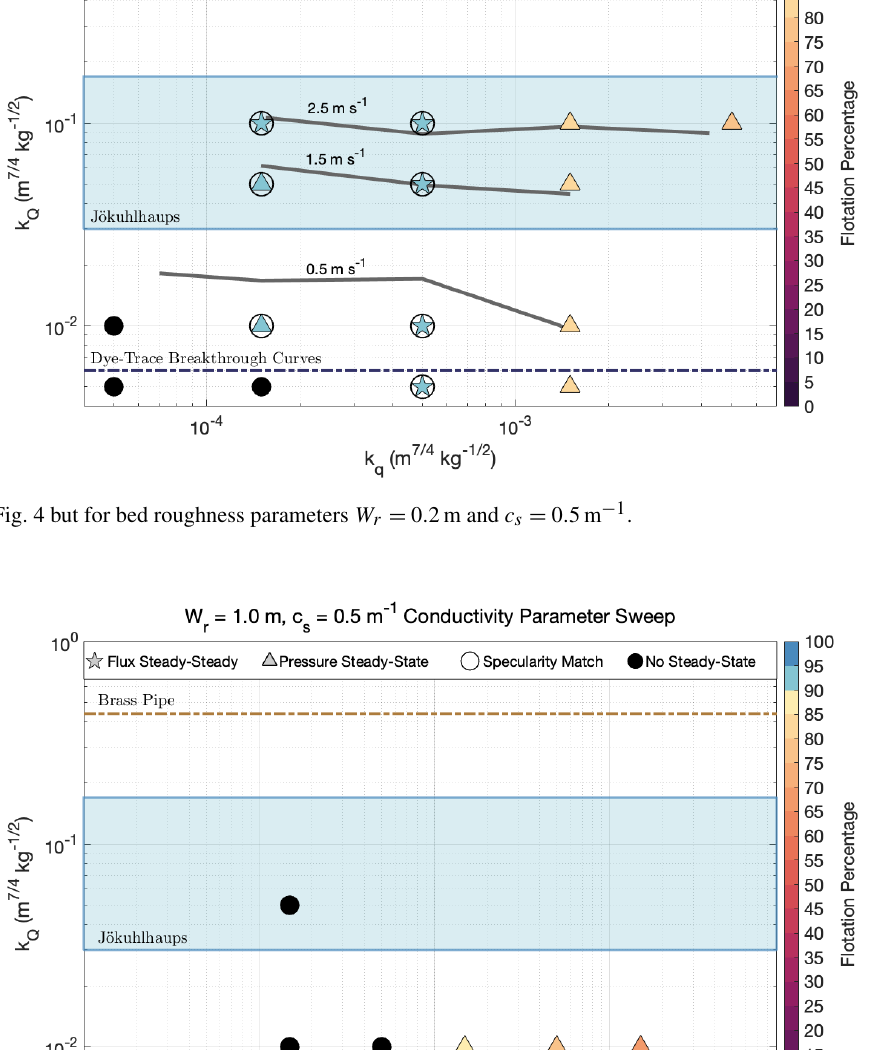
The Cryosphere, 16, 3575–3599,